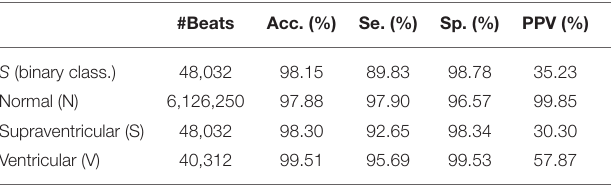
TABLE 3 | Classifier performance considering single beats regardless of the patient.